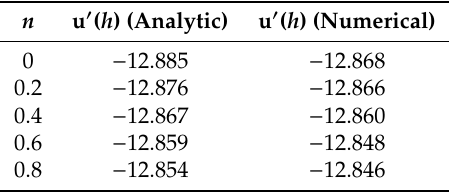
Table 1. Numerical values for wall skin friction obtained by analytical and numerical methods when Q = 2, α = ε = 0.2, β = x = 0.5, We = 0.01, M = 0.8 are